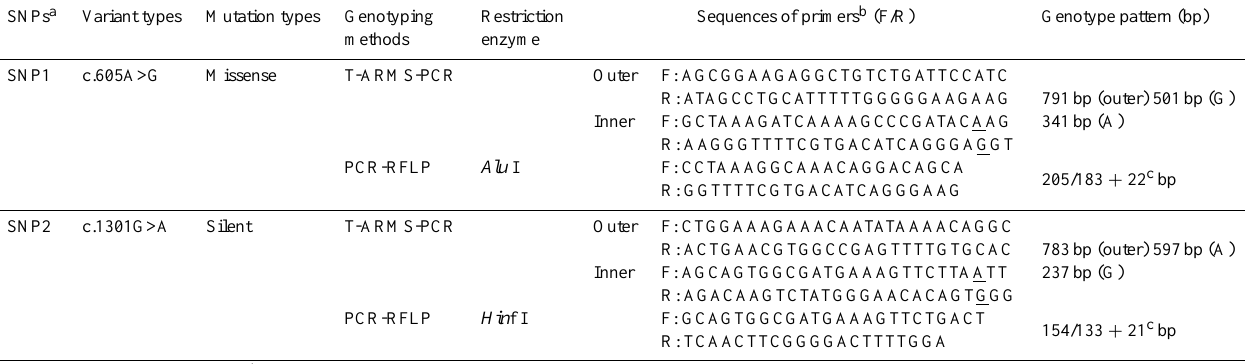
Table 2. PCR primers for genetic variants identified in the bovine NRIP1 gene.